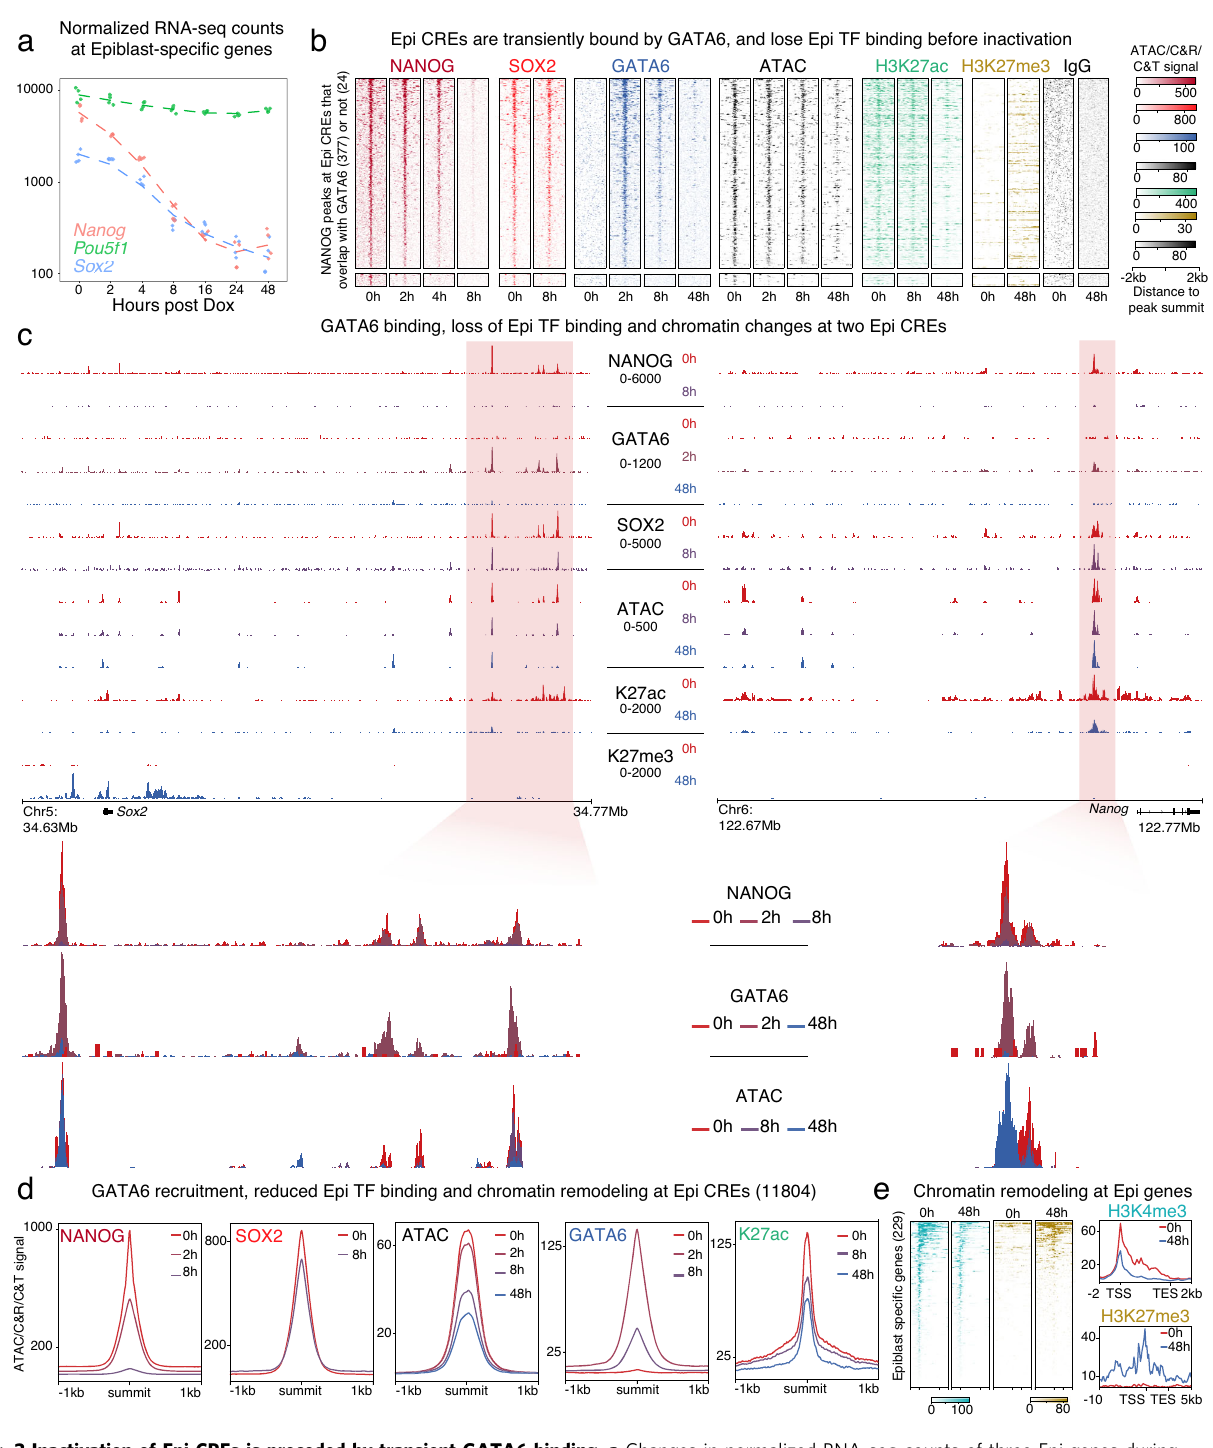
Fig. 3 Inactivation of Epi CREs is preceded by transient GATA6 binding. a Changes in normalized RNA-seq counts of three Epi genes during differentiation. As in blastocysts, Nanog mRNA levels decreased faster than Sox2 , while Pou5f1 was less affected b Heatmap shows gradual loss of NANOG and SOX2 at Epi CREs, concomitant with the transient binding of GATA6 at these loci, and progressive loss of ATAC signal and H3K27ac. A few CREs displayed increase in H3K27me3. c Browser view showing changes of NANOG, SOX2, and GATA6 binding, along with changes in ATAC signal, H3K4me3 and H3K27me3 at the Nanog and Sox2 loci. While Nanog was silenced independently of H3K27me3, Sox2 accumulated this mark over its gene bodies and surrounding regions. d Median pro fi le plots depicting quick loss of NANOG and SOX2 with simultaneous GATA6 recruitment, and consequently a decrease in ATAC signal and H3K27ac. e Change in H3K4me3 and H3K27me3 surrounding Epi TSSs at 0 and 48 h. Some Epi genes accumulated H3K27me3 during